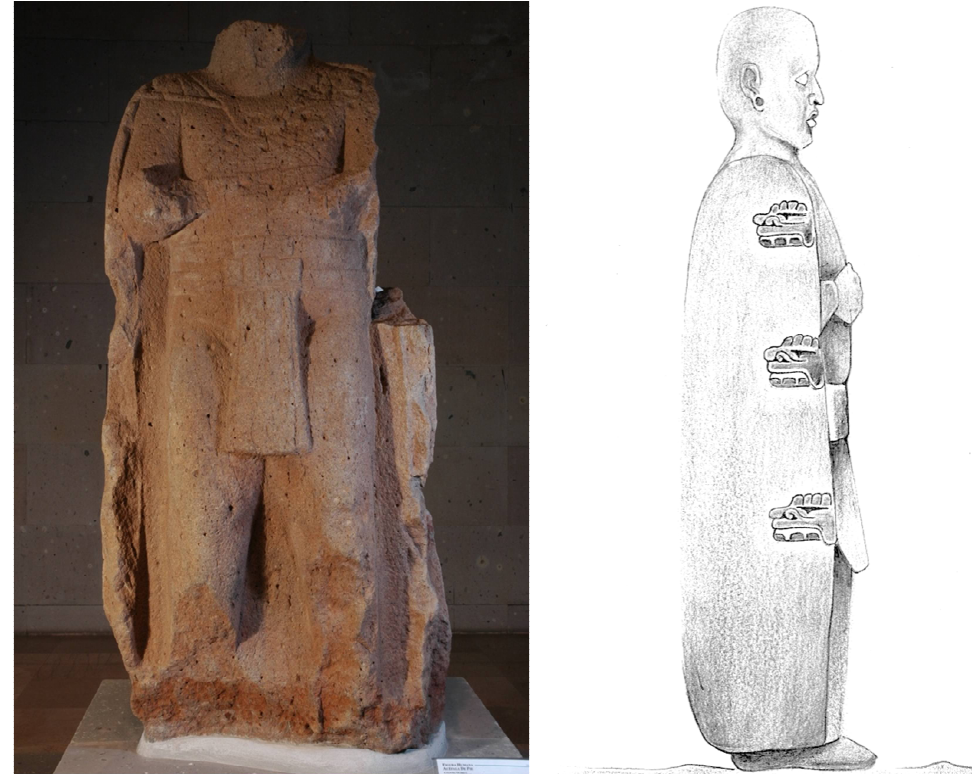
Figure 4. Left —Laguna de los Cerros Monument 19. An early representation of how people used serpents to legitimize their status and identity. Photo taken by Hirokazo Kotegawa at the National Museum of Anthropology, Xalapa, Veracruz, Mexico. Right —Rendition of LCM-19 showing three serpent heads carved on the right-side view of elongated cape. A head added to the drawing brings the full character of Quetzalcoatl to life. Drawing by 2nd author.